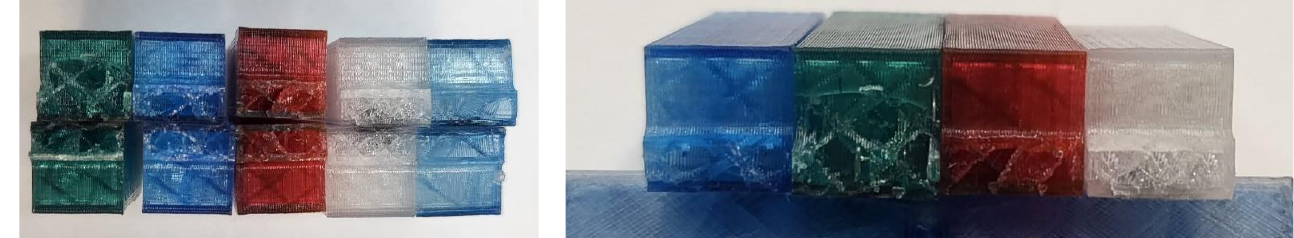
Figure 21. Charpy test specimens.